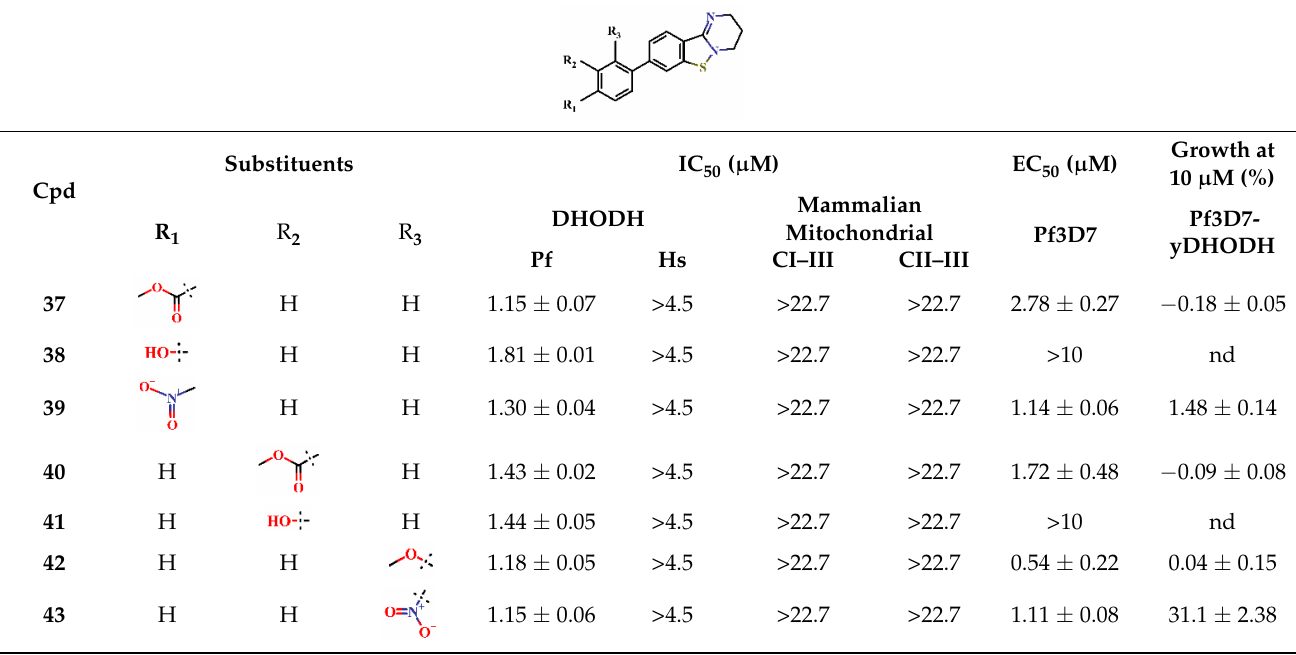
Table 4. Antimalarial activity of Compound 30